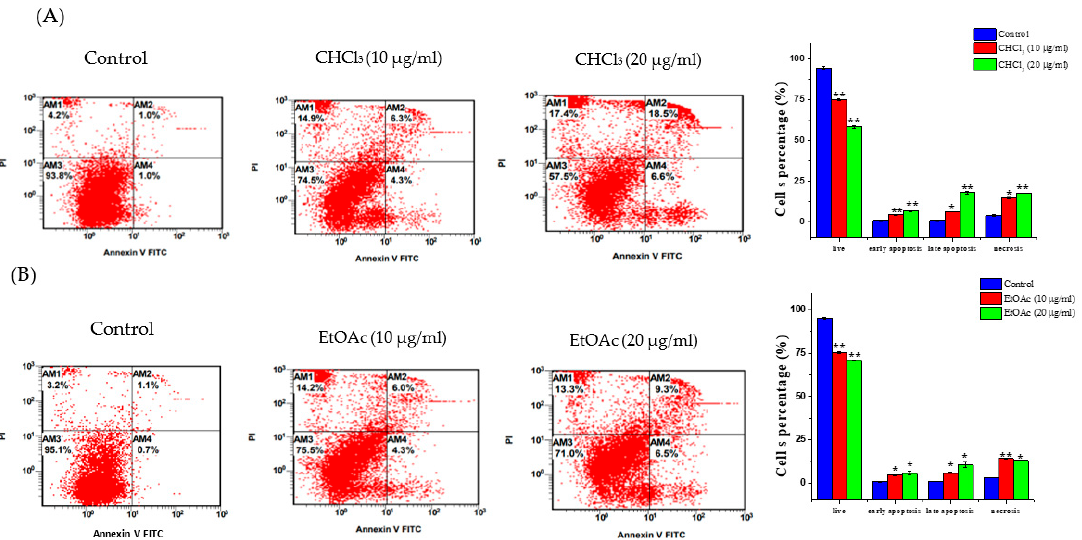
Figure 6. Effects of E. saudiarabica CHCl 3 and EtOAc fractions on stages of apoptosis. ( A ) The MCF-7 cells were incubated with 10 and 20 µ g/mL of CHCl 3 fraction for 24 h and were then collected and stained with Annexin V/PI, followed by FACS analysis. The bars display FACS-quantification analysis. ( B ) The FACS and bar graphs showing the percentages of MCF-7 cells treated with 10 and 20 µg/mL of CHCl 3 fraction for 24 h. Data are mean ± SEM of three independent experiments, where * denotes p ≤ 0.05 and ** denotes p ≤ 0.01 vs. control, as measured by Student’s t -test.